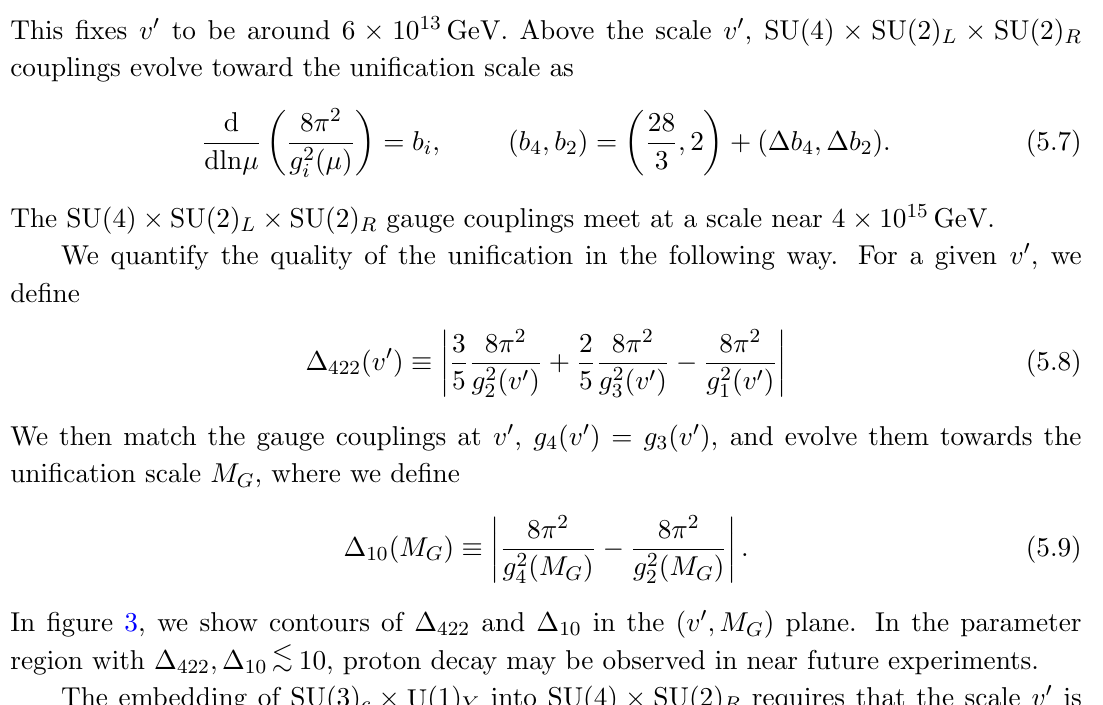
Figure 2 . The quality of gauge coupling uni(cid:12)cation as a function of v 0 and the uni(cid:12)cation scale M G . The vertical band shows the prediction for v 0 from the vanishing Higgs quartic